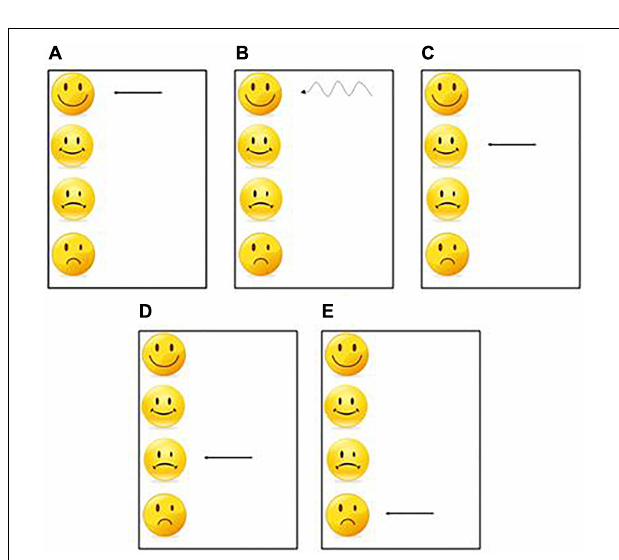
FIGURE 3 | One of these 5 feedbacks was presented at the end of each practice trial. (A) The first feedback was displayed when the participant had an average synchronization between − 20 ms and + 20 ms and a standard deviation less than 20 ms. (B) The second feedback was displayed when the participant had an average synchronization between − 20 ms and + 20 ms and a standard deviation greater than 20 ms. (C) The 3 rd feedback was displayed when the participant had an average synchronization between − 40 ms and − 20 ms or between + 20 and + 40 ms. (D) The 4 th feedback